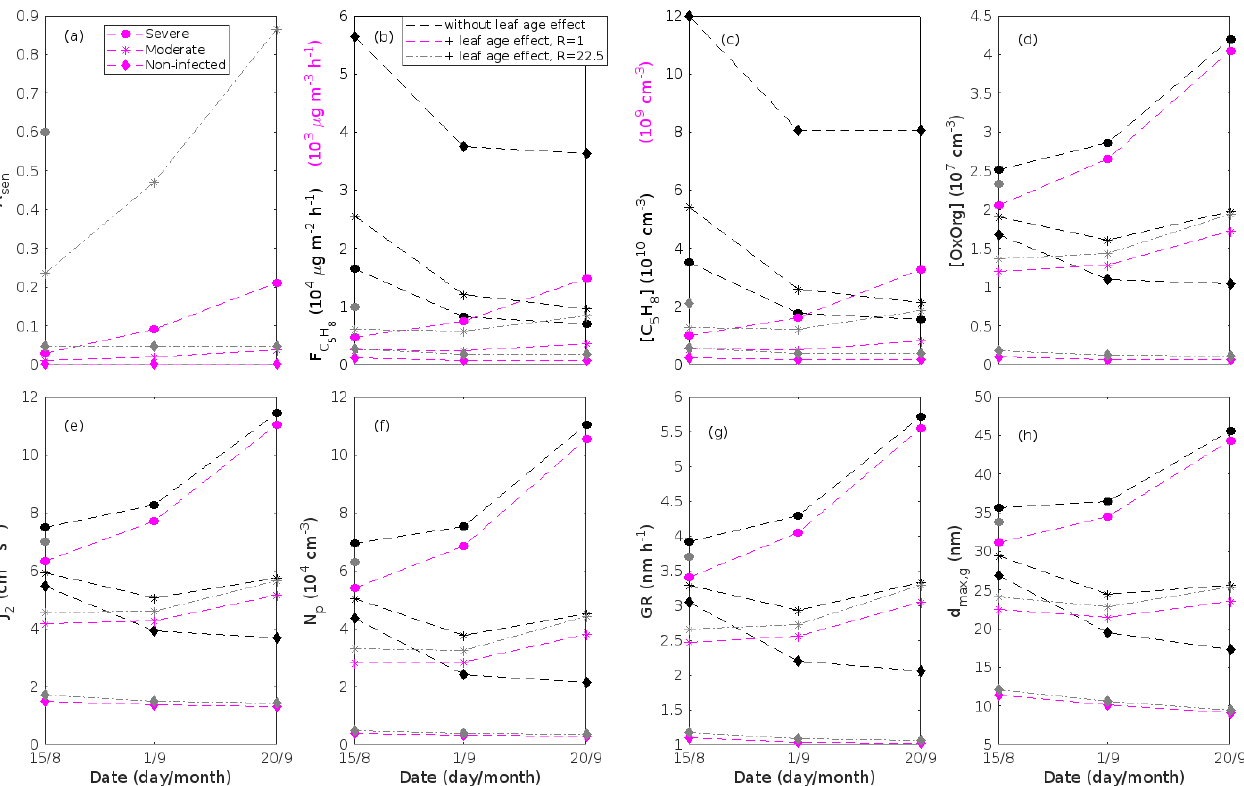
Figure B4. A poplar stand infected by rust in comparison to a non-infected poplar stand simulated with and without considering the impact of leaf age on the rates of isoprene emissions. (a) The fraction of isoprene emitted in comparison to simulations where the leaf age effect was not considered. (b) Canopy emissions of isoprene and atmospheric concentrations of (c) isoprene and (d) OxOrg. The units provided in black in (b) – (c) are connected to black and grey data points, while the units in magenta in (b) – (c) are connected to magenta data points. (e) Formation rate of 2nm particles, (f) number concentrations of formed particles, (g) growth rates of newly formed particles, and (h) the daily maxima diameter of the growing particle mode. The values of other parameters during these simulations are the same as in Fig. 8. Grey markers are for simulations where the emission of isoprene was reduced sufficiently for R to be just under 22.5. Symbols are used in the same way as in Fig.